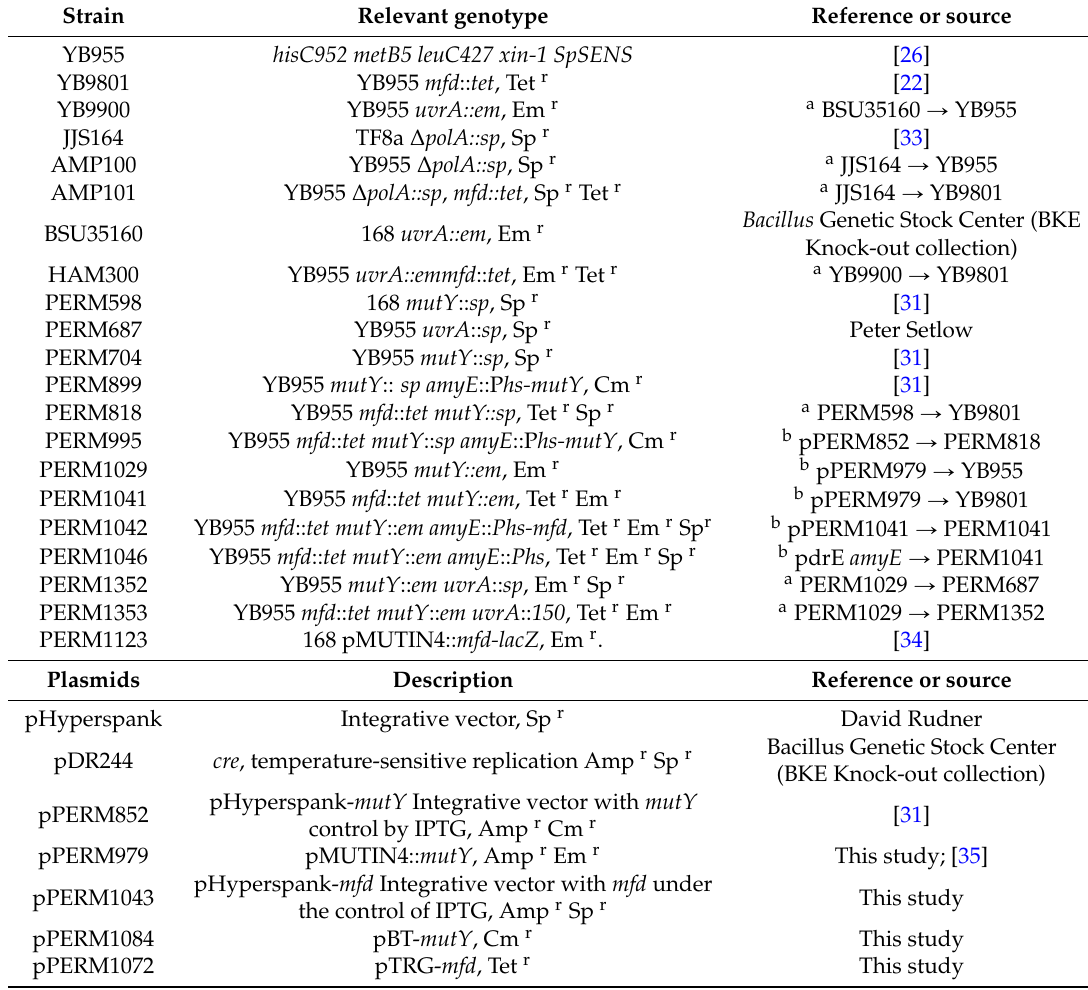
Table 1. B. subtilis strains and plasmids used in this